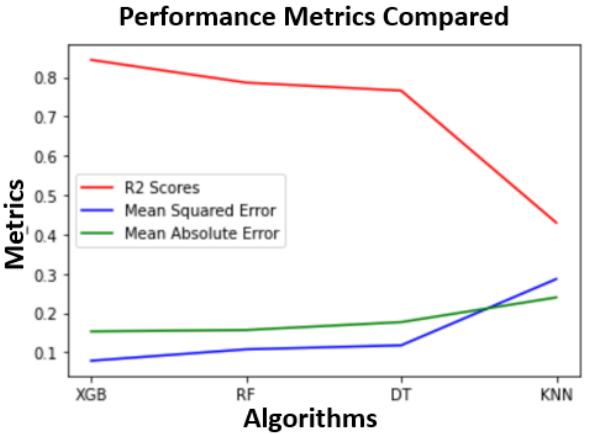
Figure 6. Comparison of Performance metrics of all the 4 different algorithms.